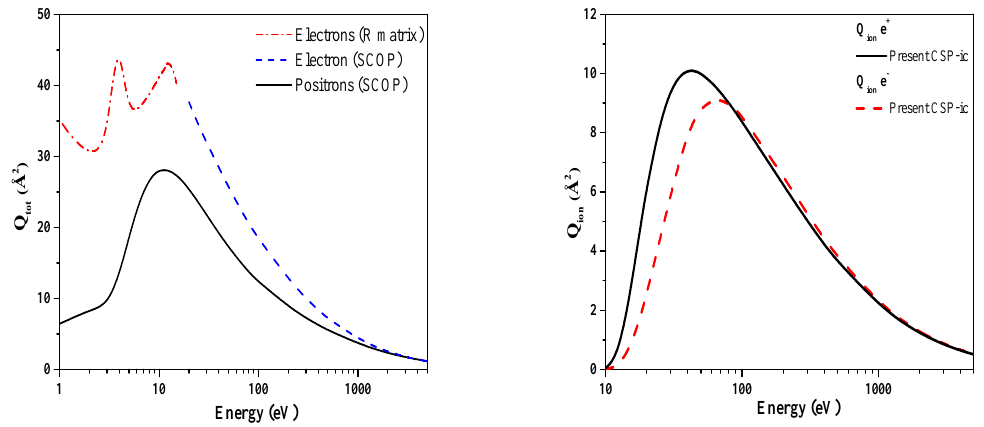
Figure 9. Left : Total cross section for e − /e + -propene interaction [223]. Right : Total ionization cross section for e − /e + -propene interaction [223].